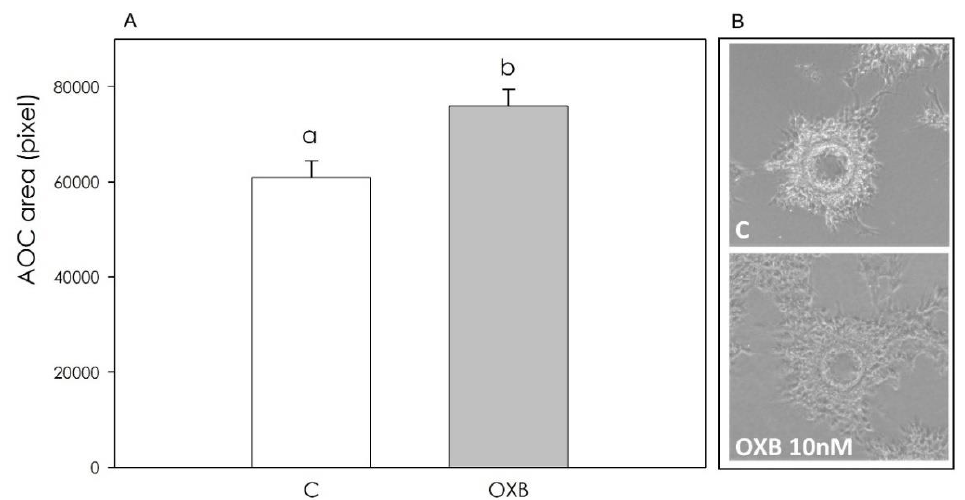
Figure 9. Effect of the 72 h treatment with OXB (10 nM) on aortic endothelial cell (AOC) growth in fibrin gels. Panel ( A ): data, expressed as pixels, represent the mean ± SEM of six replicates/treatment repeated in five different experiments. Different letters on the bars indicate a significant difference ( p < 0.001) among treatments as calculated by ANOVA and Scheffè’s F test. Panel ( B ): exemplary images of the AOC growing on collagen-coated MC beads in fibrin gels both after 72 h of treatment with OXB (10 nM).